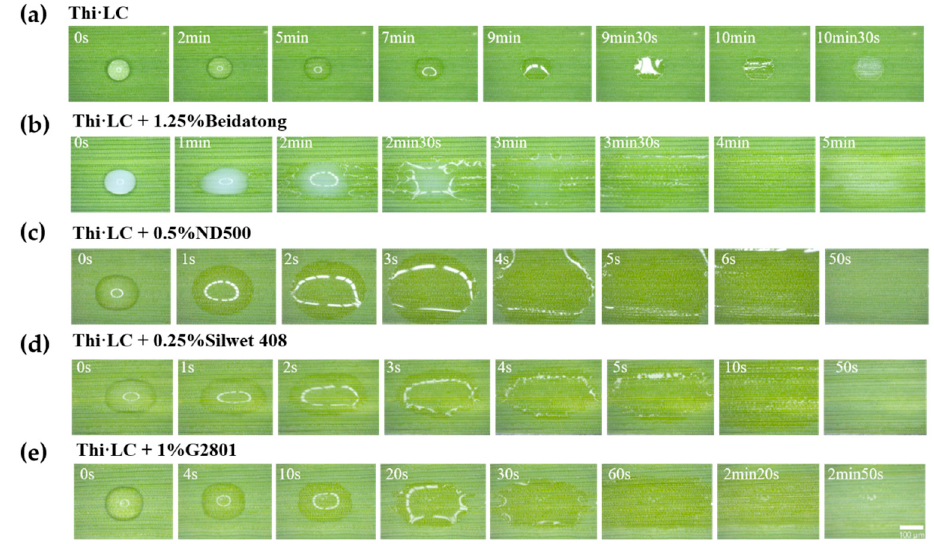
Figure 6. Deposition morphology changes of Thi · LC droplets ( a ) and Thi · LC droplets added with four adjuvants ( b – e ).